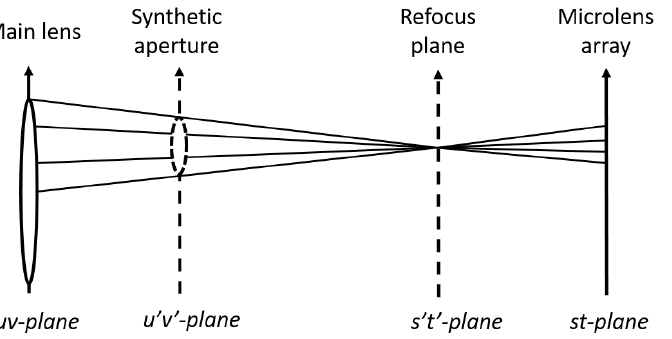
Figure 6. Conceptual model for refocusing LF image at a different depth [17]. The ( u,v ) and ( s,t ) plane are surfaces of the camera, respectively, and ( s ‘ ,t ‘) is the refocus plane.